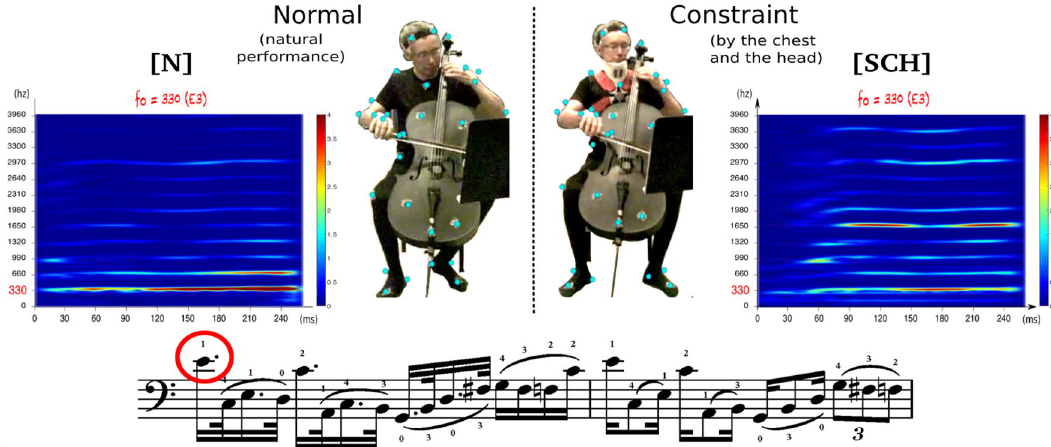
Figure 1. The musical passage and note investigated for this study. Spectrograms correspond to examples of the acoustic signal of an E4 note (the first one of this score sequence) played by the same cellist with good timbre quality (round) in the normal situation [N] and poor timbre quality (harsh) in the posturally-constrained situation [SCH] (Static Chest and